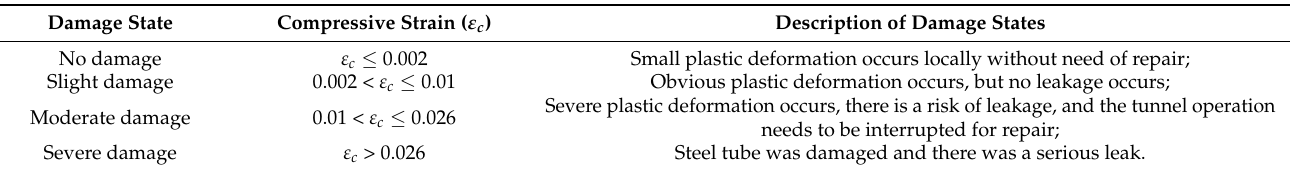
Table 4. Damage state of composite lining steel